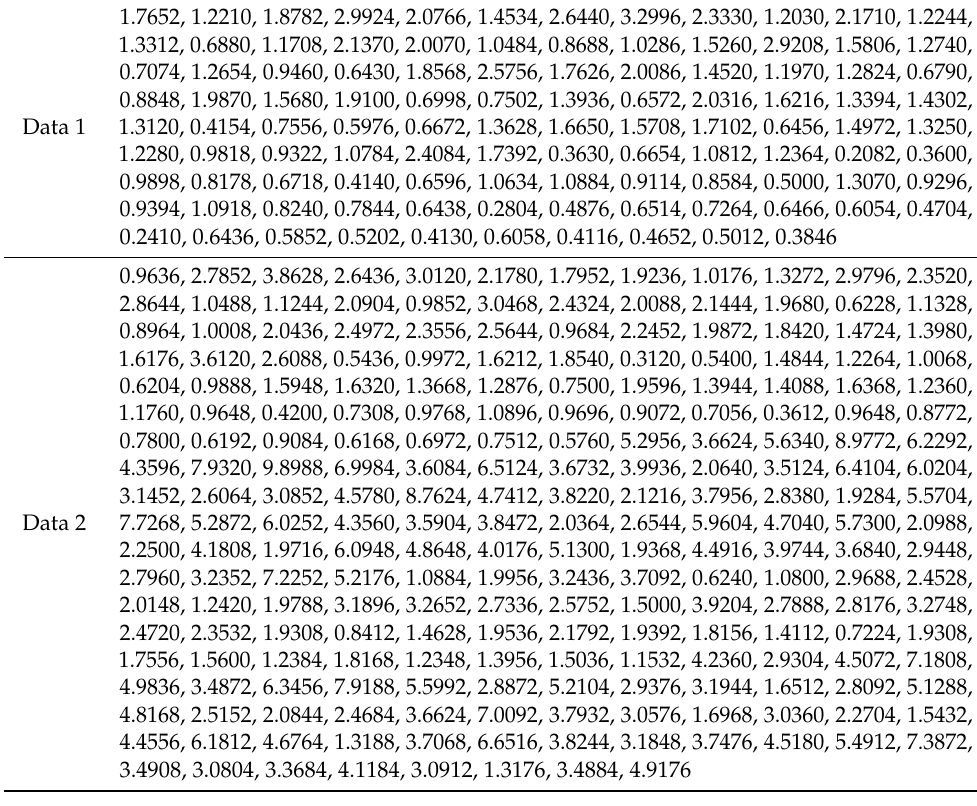
Table 3. The COVID-19